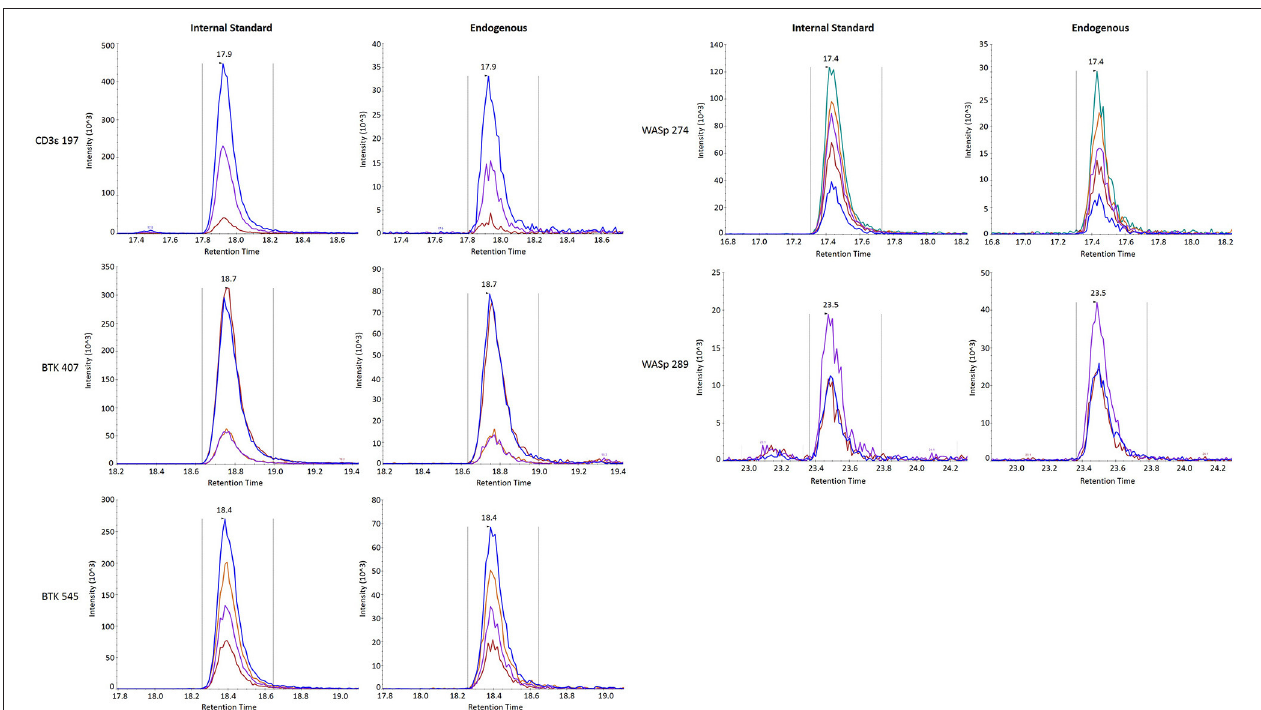
FIGURE 2 | SRM traces for internal standard (Left) and endogenous (Right) signature peptides.